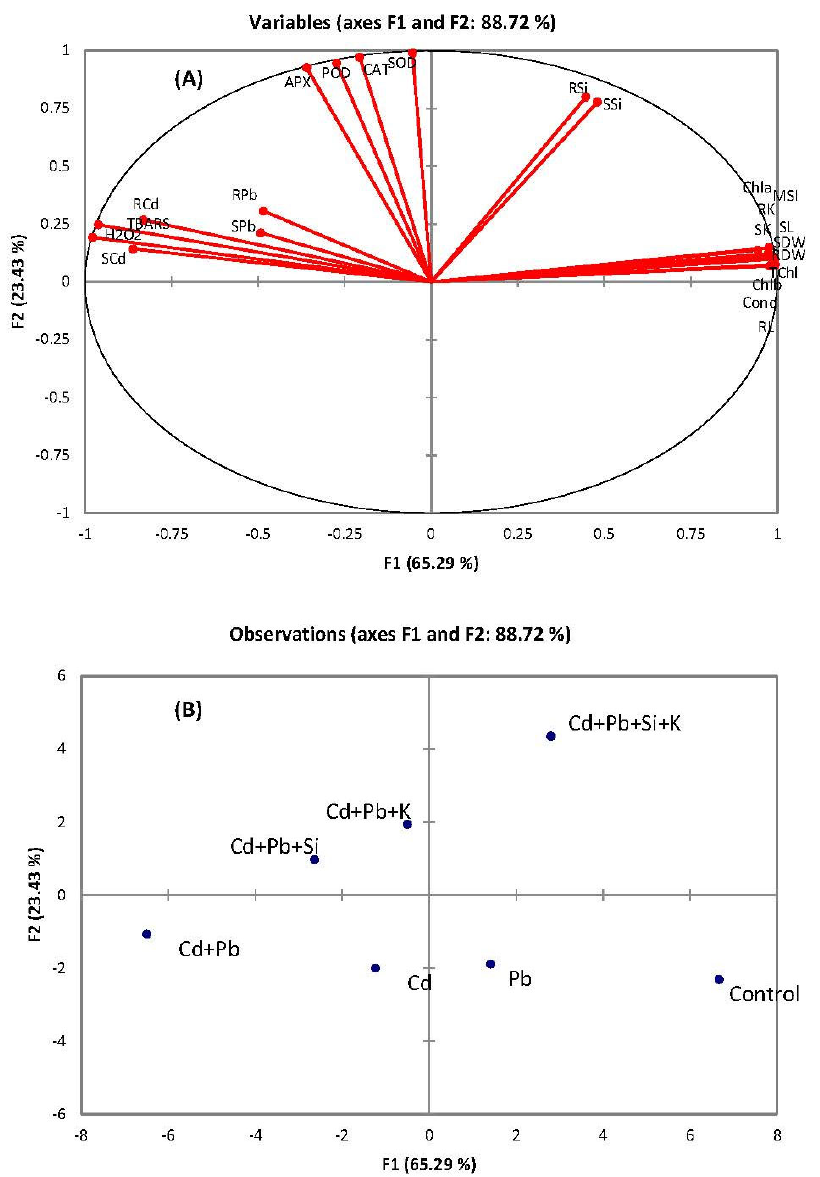
Figure 5. Principal component analysis of plant growth attributes ( A ) and treatments ( B ) of quinoa exposed to Cd and Pb treatments with and without supplementation of Si and K.